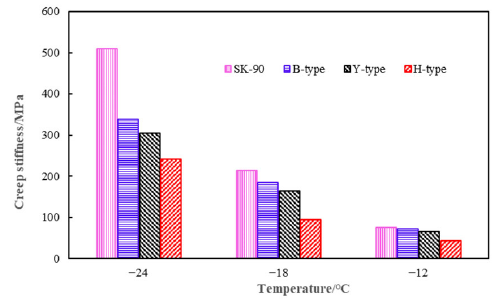
Figure 7. Creep sti ff ness of di ff erent asphalt binders.